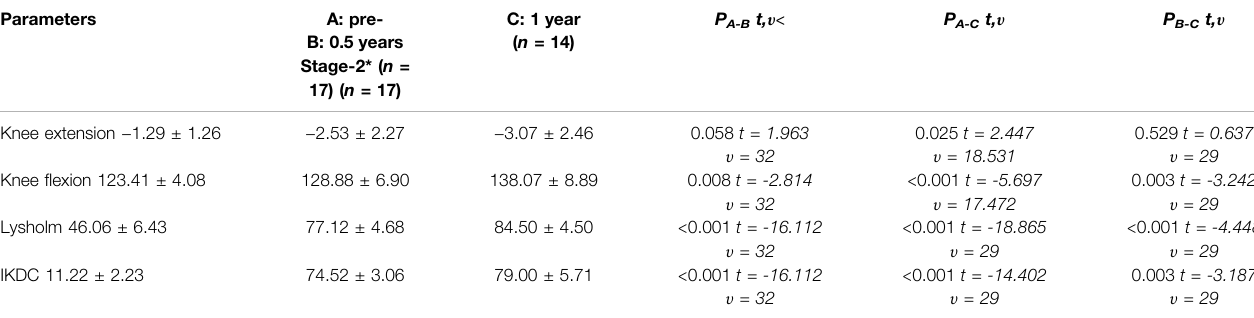
TABLE 3 | Knee range of motion and joint function at the pre-stage-2 period and follow-ups. Parameters